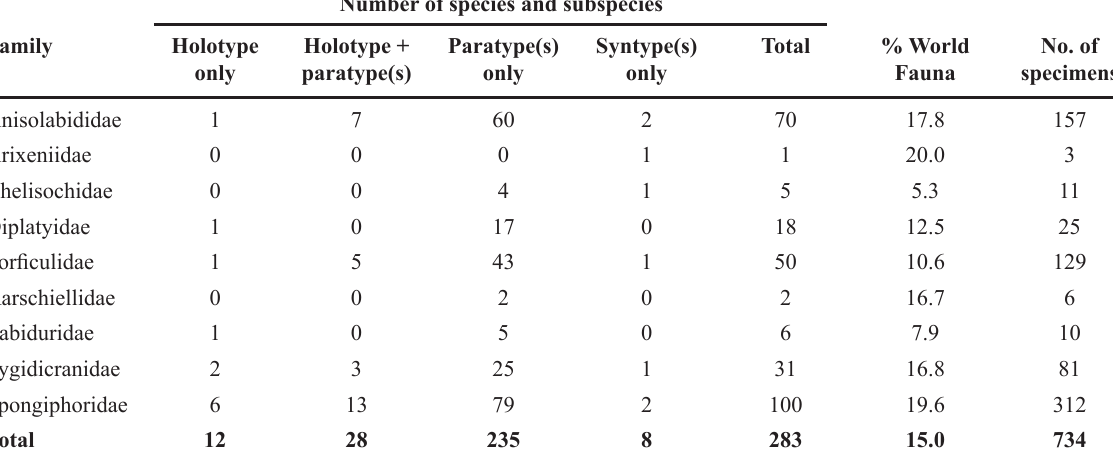
Table 4. Number of Dermaptera species and subspecies represented by type specimens at the Manchester Museum, by family (nomenclature follows Steinmann 1989c, complemented by latest updates from Engel & Haas